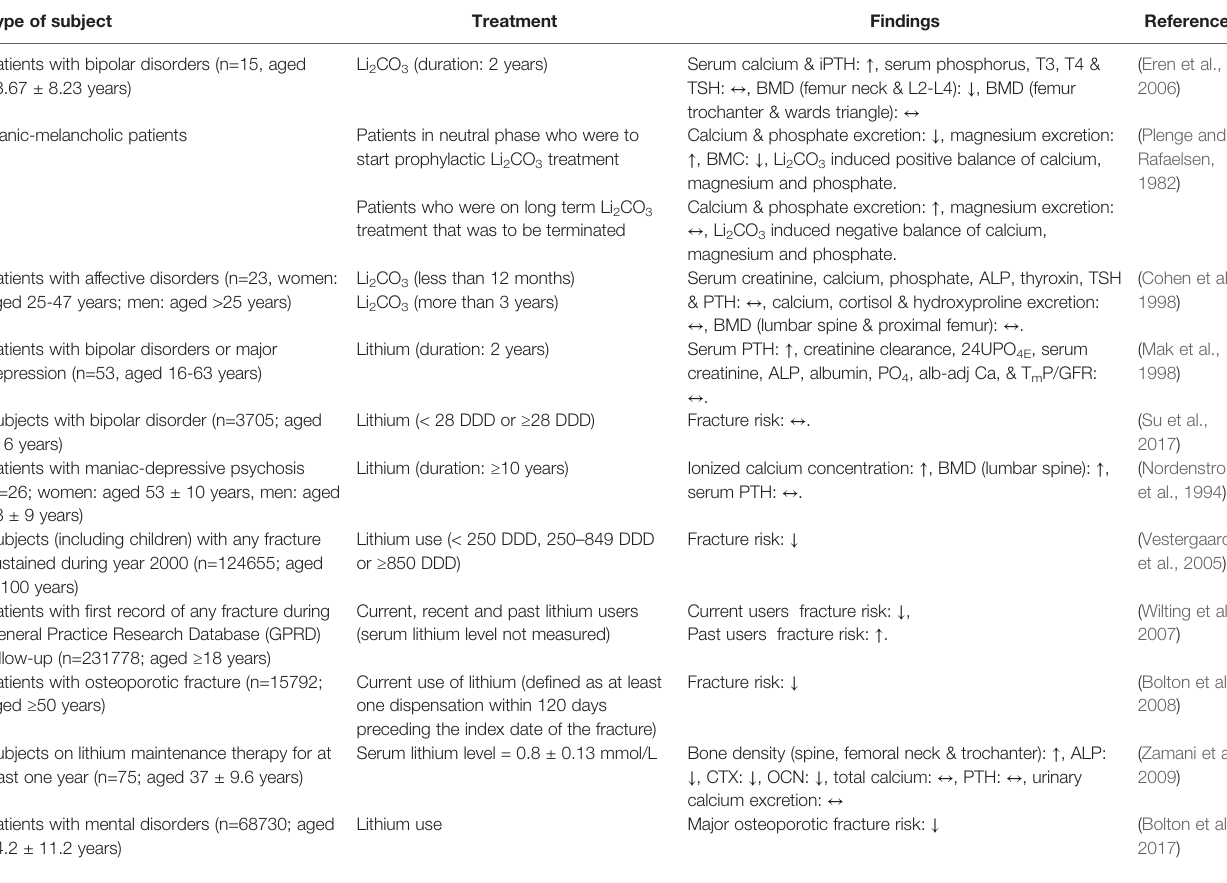
TABLE 2 | Effects of lithium on bone in